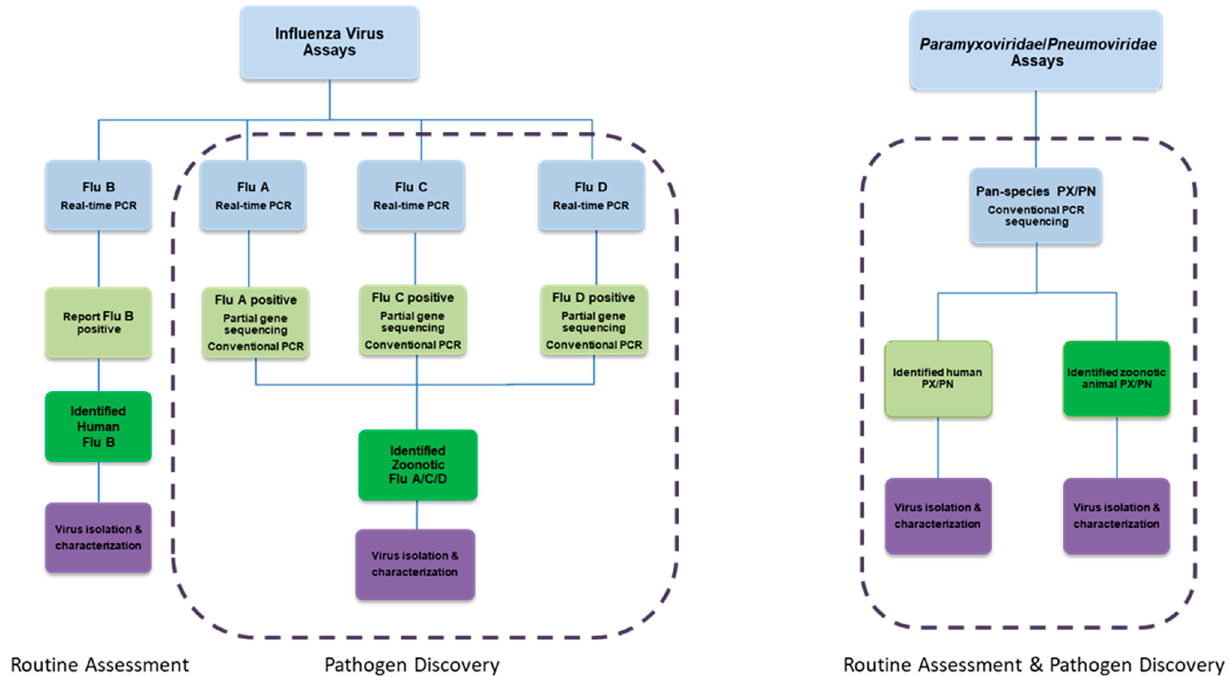
Figure 5. Molecular detection algorithm for influenza viruses and pan- Paramyxoviridae / Pneumoviridae viruses. The influenza virus assay utilizes real-time (q) RT-PCR to differentiate the various strains of influenza virus. For influenza A, C, and D viruses, this is followed by conventional RT-PCR assays for subtyping. In contrast, the Paramyxoviridae / Pneumoviridae algorithm begins with a pan-species conventional RT-PCR approach to identify human and animal viruses of the Paramyxoviridae and Pneumoviridae families. Viruses are further characterized with Sanger sequencing.